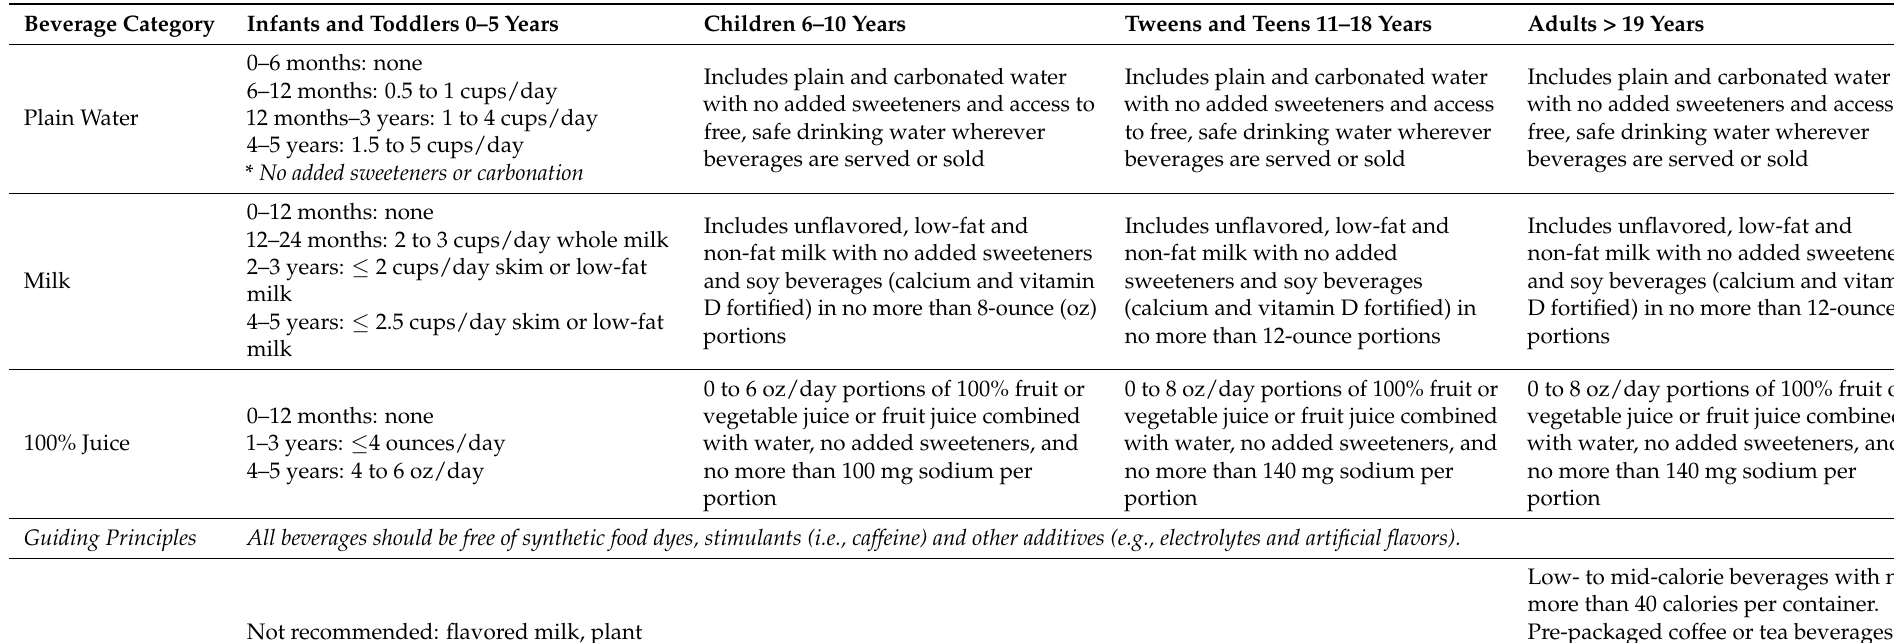
Table 1. U.S. Healthy Eating Research healthy beverage recommendations by beverage category and age